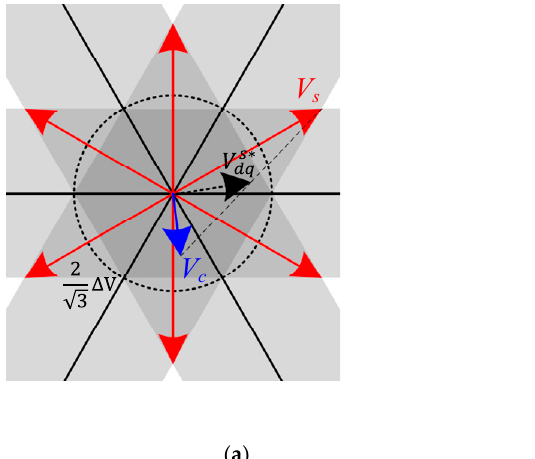
Figure 3. Conventional PWM shift method to reconstruct the current: ( a ) Example of V s ∗ , ( b ) switching pattern.